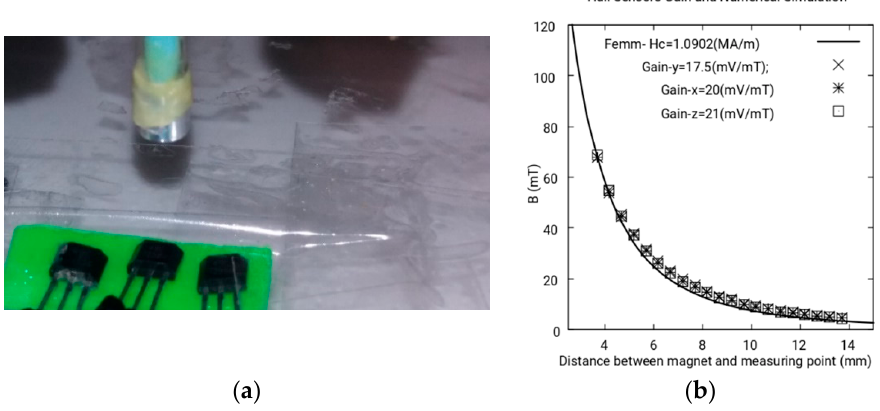
Figure 7. ( a ) CNC tip on the Hall sensors; ( b ) calculation of the gain of the Hall sensors.